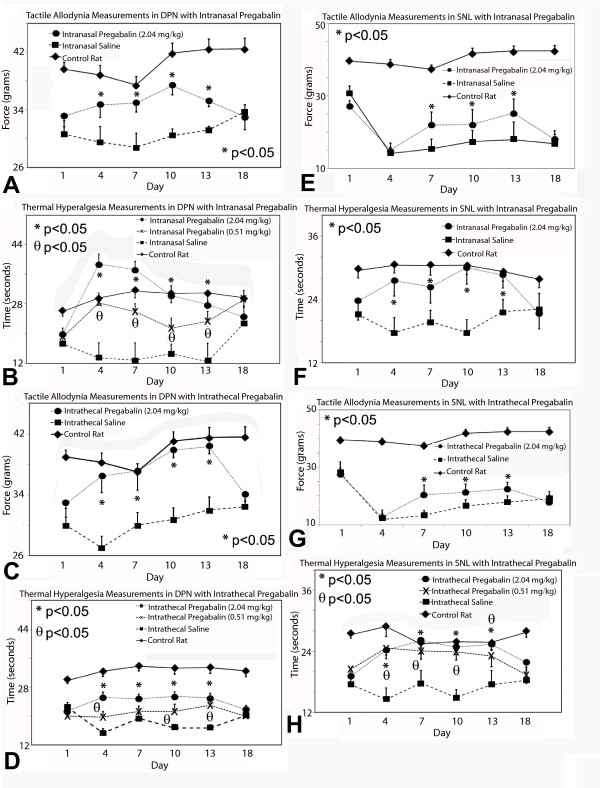
Behavioral testing results for both models of neuropathic pain. Tactile (A) and thermal (B) sensory testing data for rats with or without (control) diabetes and diabetic peripheral neuropathy (DPN) receiving intranasal pregabalin are presented for multiple doses of pregabalin or saline. Intrathecal pregabalin delivery was also followed by measurements of tactile allodynia (C) and thermal hyperalgesia in diabetic rats (D). High doses of either intranasal or intrathecal pregabalin impacted upon these neuropathic pain behaviours in DPN. For rats with or without spinal nerve ligation receiving intranasal pregabalin, tactile (E) and thermal (F) sensory testing data are presented; intranasal pregabalin at high dose impacted upon both measures of neuropathic pain behaviour. Finally, intrathecal pregabalin also impacted upon both tactile allodynia (G) and thermal hyperalgesia (H) due to spinal nerve ligation when compared to saline delivery. Significant differences were detected between the diabetic rats receiving high dose (2.04 mg/kg/d) (*) and medium dose (0.51 mg/kg/d) (θ) pregabalin as compared to diabetic rats receiving saline delivery (non-matched ANOVA tests, F-values range between 1.98-22.86 for indicated groups and time points, n ≥ 5, p < 0.0125 after Bonferroni correction). Significant differences were detected between rats with spinal nerve ligation receiving high dose (2.04 mg/kg/d) (*) and medium dose (0.51 mg/kg/d) (θ) pregabalin as compared to rats with spinal nerve ligation receiving saline delivery (non-matched ANOVA tests, F-values range between 2.25-8.11 for indicated groups and time points, n ≥ 5, p < 0.0125 after Bonferroni correction) [n = 5-6 rats in each cohort for each time point]. Data for rats receiving low dose pregabalin were similar to data for rats receiving saline and are not shown.